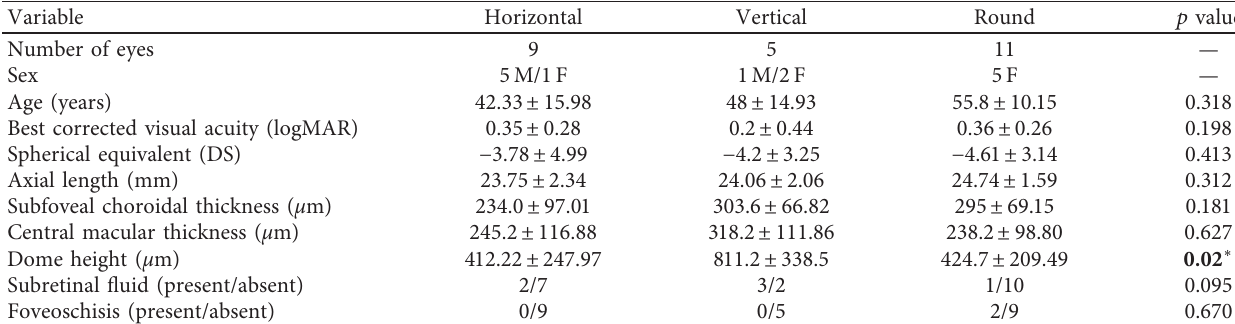
Table 2: Comparison of parameters among different orientations of myopic domes.